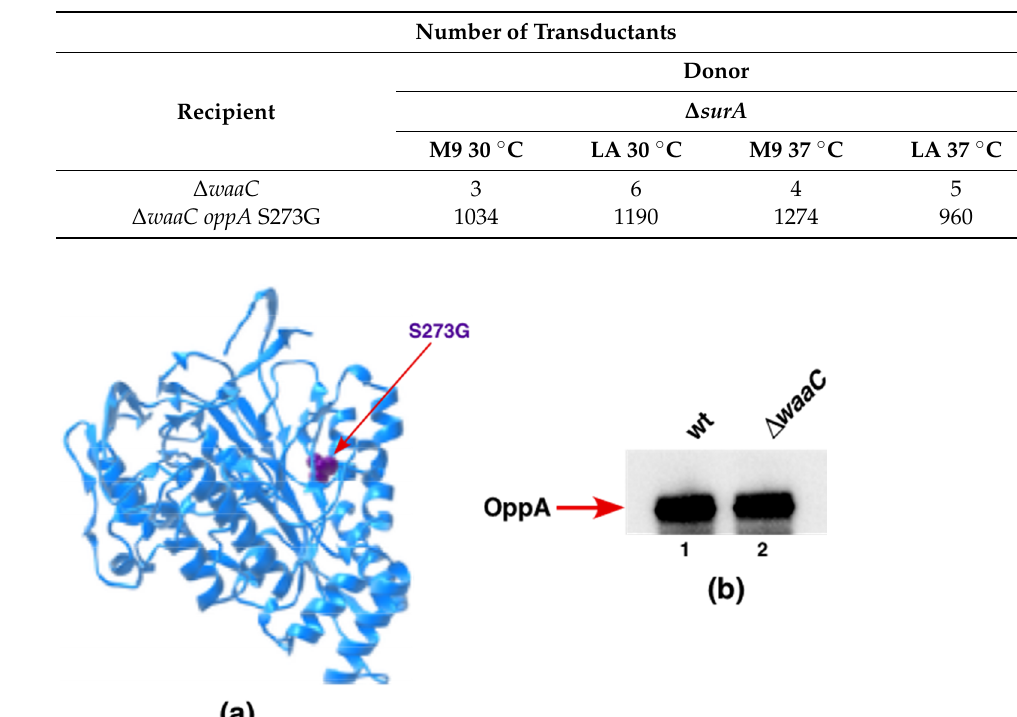
Figure 14. A single-amino-acid alteration to OppA S273 overcomes the synthetic lethality of Δ( waaC surA ) bacteria. ( a ) Position of S273 in the structure of OppA (PDB 3TCH). ( b ) Immunoblot analysis of total cellular extracts obtained from the wild type and its Δ waaC derivative, carrying a single-copy 3xFLAG appended to the C-terminal end of OppA, were grown in LB medium at 37 °C. Equivalent amounts of proteins were applied to a 12.5% SDS – PAGE, and resolved proteins were transferred by Western blotting. Immunoblots were treated with an M2 monoclonal antibody to reveal OppA – 3xFLAG. The arrow indicates the position of OppA. Table 4. Single amino exchange in the oppA coding sequence S273G allows for the construction of Δ( waaC eptB ) deletion. Determination of the viability of Δ( waaC surA ) derivatives in the presence or absence of oppA S273G suppressor mutation by bacteriophage-mediated transductions. Numbers depict the number of transductants using the equivalent amount of recipient.